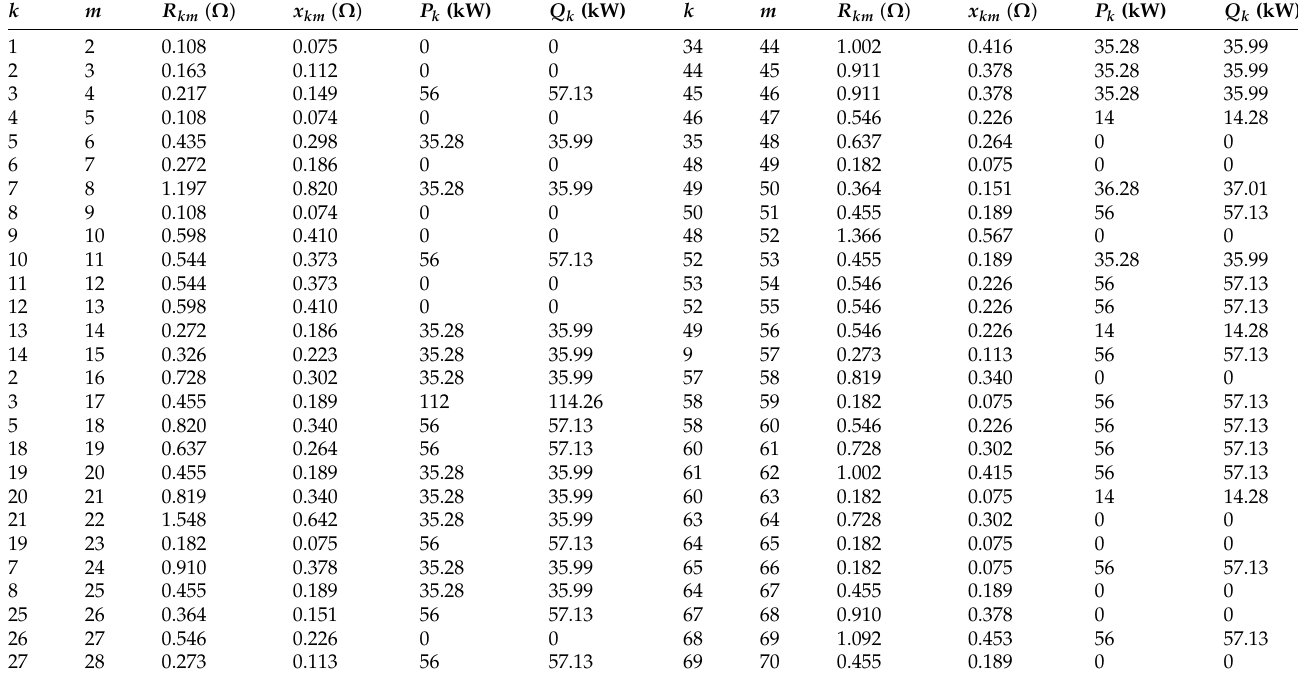
Figure 10 Bus voltages at each bus after compensation by different techniques for 85-bus test system.